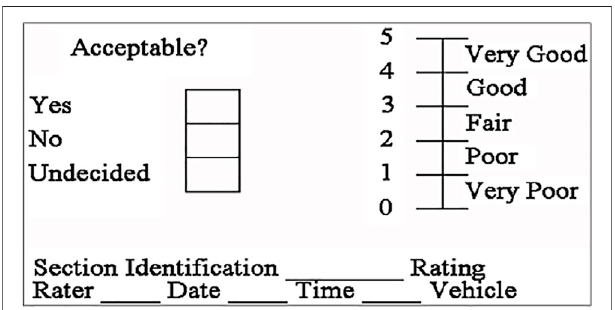
FIGURE 1 | Individual present serviceability rating form.